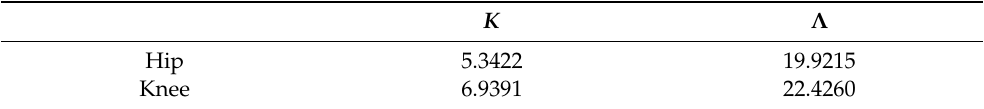
Table 4. Controller gains tuned by